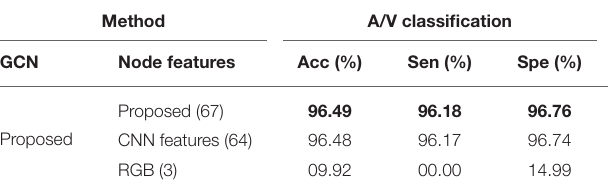
TABLE 3 | Node feature contribution analysis using the AV-DRIVE